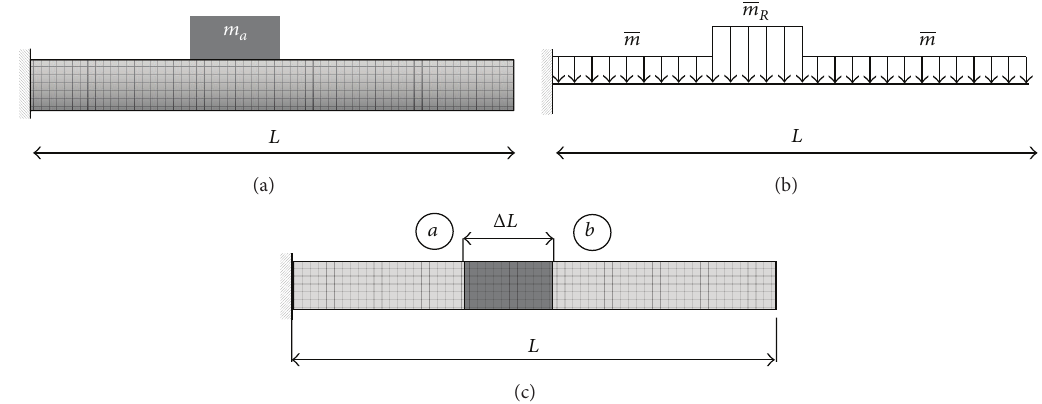
Figure 2: Cantilever beam with additional mass and its continuous and finite element models.